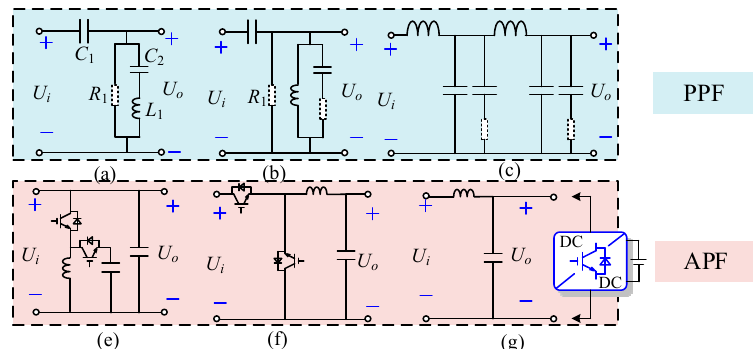
Figure 1. Basic structure of a DC filter: ( a ) Double-tuned high-pass filter, ( b ) C-type filter, ( c ) Six-order damping-CBSF, and ( e , f , g ) APF.